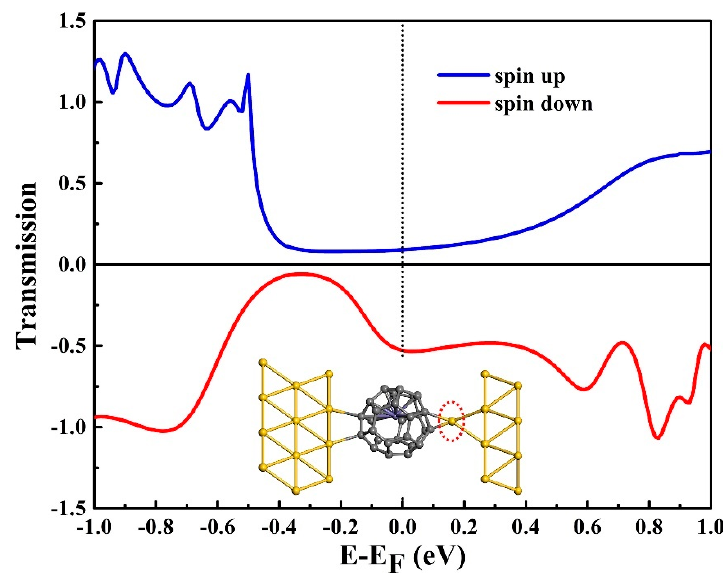
Figure 6. Spin-resolved transmission spectra of the molecular junction of Au tip bonding with Fe@C 28 . Insert: bonded Fe@C 28 junction. The bonding area is denoted by the red dotted circle.